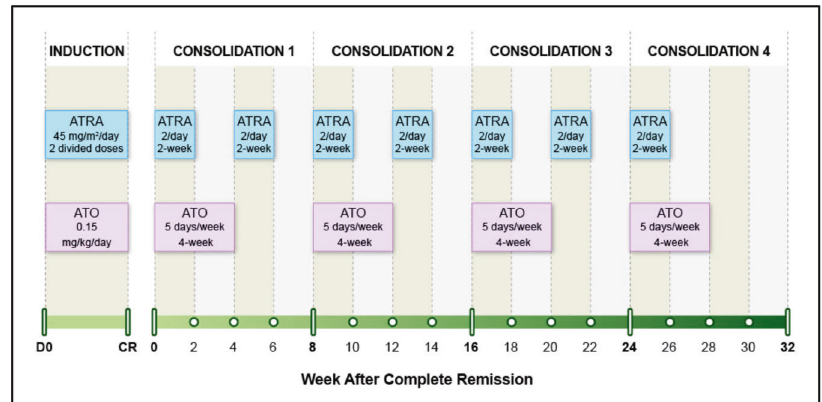
Fig. 3 ATRA plus ATO treatment schedule. ATRA retinoic acid, ATO arsenic trioxide, mg milligram, 2/day two divided